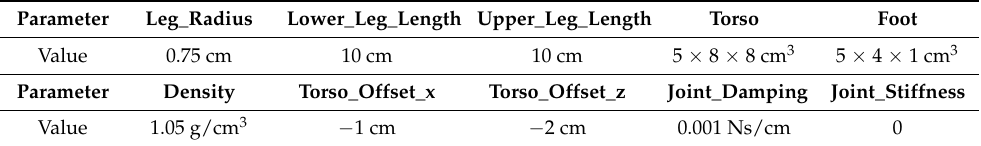
Table 2. Physical property parameters of the biped robot.